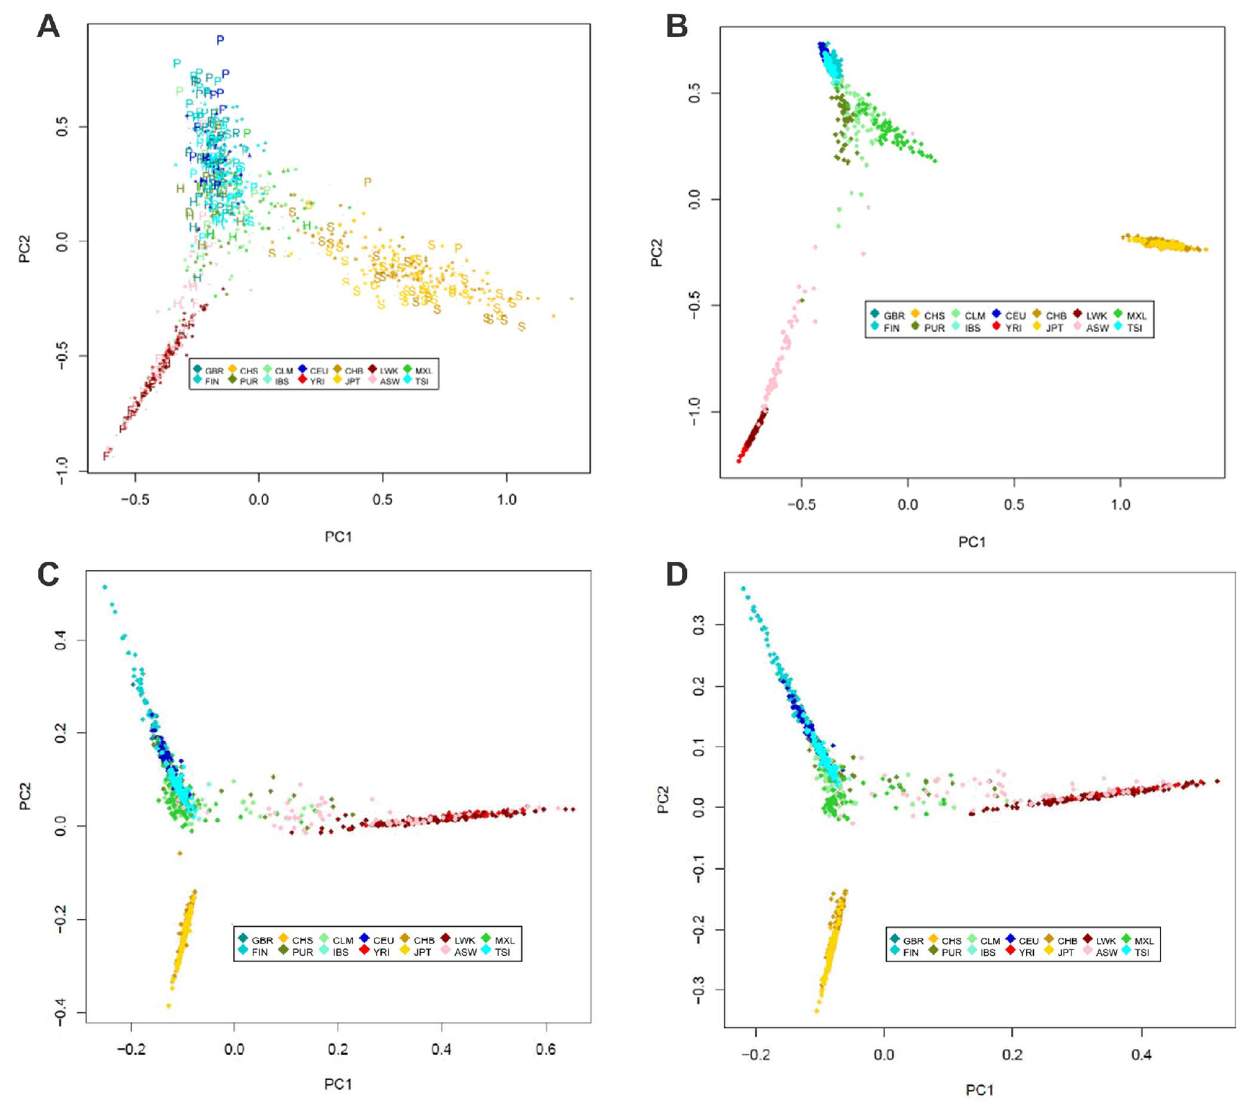
Figure 1. Principal Component analysis of the pairwise IBD distances between 1000 Genomes samples using MHC region marker (A), genome-wide markers (B), and using markers of regions with similar variants’ density (C, chr9 : 116,750,000–121,650,000), with a recombination rate (D, chr9:800,000–5,700,000). (A) The presence of the most frequent ancestry specific HLA haplotype in the samples of the 1000 Genomes project using MHC region markers . Principal component analysis of the 103 K variants from the MHC region in the 1000 Genomes samples. PC1 captures 6.00% of total variance; PC2 captures 5.05%. The PCA analysis is based on publicly available SNPs. In order to integrate the SNP based information to the HLA allele information, individual spots are replaced by letters when a frequent HLA haplotype is predicted when the HLA typing is phased using HLA haplotype frequencies. The so called ‘‘frequent’’ haplotypes are defined in an ancestry specific manner: P for frequent HLA haplotypes in Europeans, S for frequent HLA haplotype in Asians, H for frequent HLA haplotype in Hispanics and F for frequent haplotype in Africans. The detailed list of the frequent haplotypes is presented in supplementary information. Frequent haplotypes and definition of overlap between ancestries were documented in a recent modeling effort for the development of haplobank. (B) Principal Component analysis of the pairwise IBD distances between 1000 Genomes samples using genome-wide markers . Principal component analysis of 100 K variants selected at random throughout of the genome in the 1000 Genomes samples. PC1 captures 55.16% of total variance PC2 captures 41.96%. The representation of distances computed from genome-wide SNPS clearly identifies samples of European, Asian and African ancestries. The results are consistent with self-declared ancestry and the admixed nature of several populations. There are however a few notable exceptions: NA20314 from south west African Americans (ASW) clusters with Mexicans (MXL), NA20291 from ASW clusters with LWK, and HG01108 from the Puerto Rican (PUR) who clusters with the majority of Africans Americans (ASW). In addition, four Columbians (CLM: HG01342, HG01390, HG01462, HG01551) and three African Americans (ASW: NA20278, NA20299, NA20414) cluster together away from their groups. These are also clustering far from their self-declared ancestry in the MHC centered analysis. This most likely reflects their genome-wide ancestry rather than a different ancestry of the MHC. (C) Principal Component analysis of the pairwise IBD distances of 1000 Genomes samples using genome-wide markers of a region (chr9 : 116,750,000–121,650,000) with a variants’ density that is similar to the MHC region . Principal component analysis of 100 K variants selected at random throughout of the genome in the 1000 Genomes samples. PC1 captures 2.98% of total variance PC2 captures 1.56%. The representation of distances computed from genome-wide SNPS clearly identifies samples of European, Asian and African ancestries. PC1 and PC2 have been flipped to ease the comparison of the patterns in Figures 1A and 1B. (D) Principal Component analysis of the pairwise IBD distances of 1000 Genomes samples using genome-wide markers of a region (chr9:800,000– 5,700,000) with an avergage recombination rate that is similar to the MHC region . Principal component analysis of 100 K variants selected at random